Question: State the chart type depicted above.
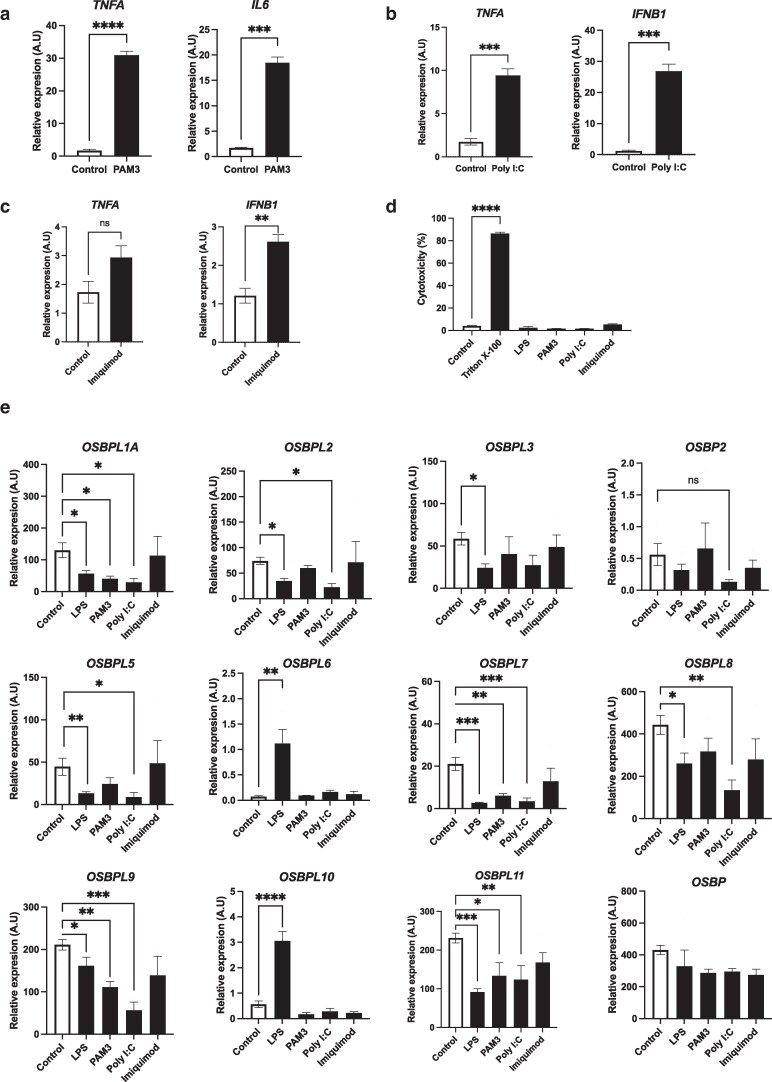
Answer: bar